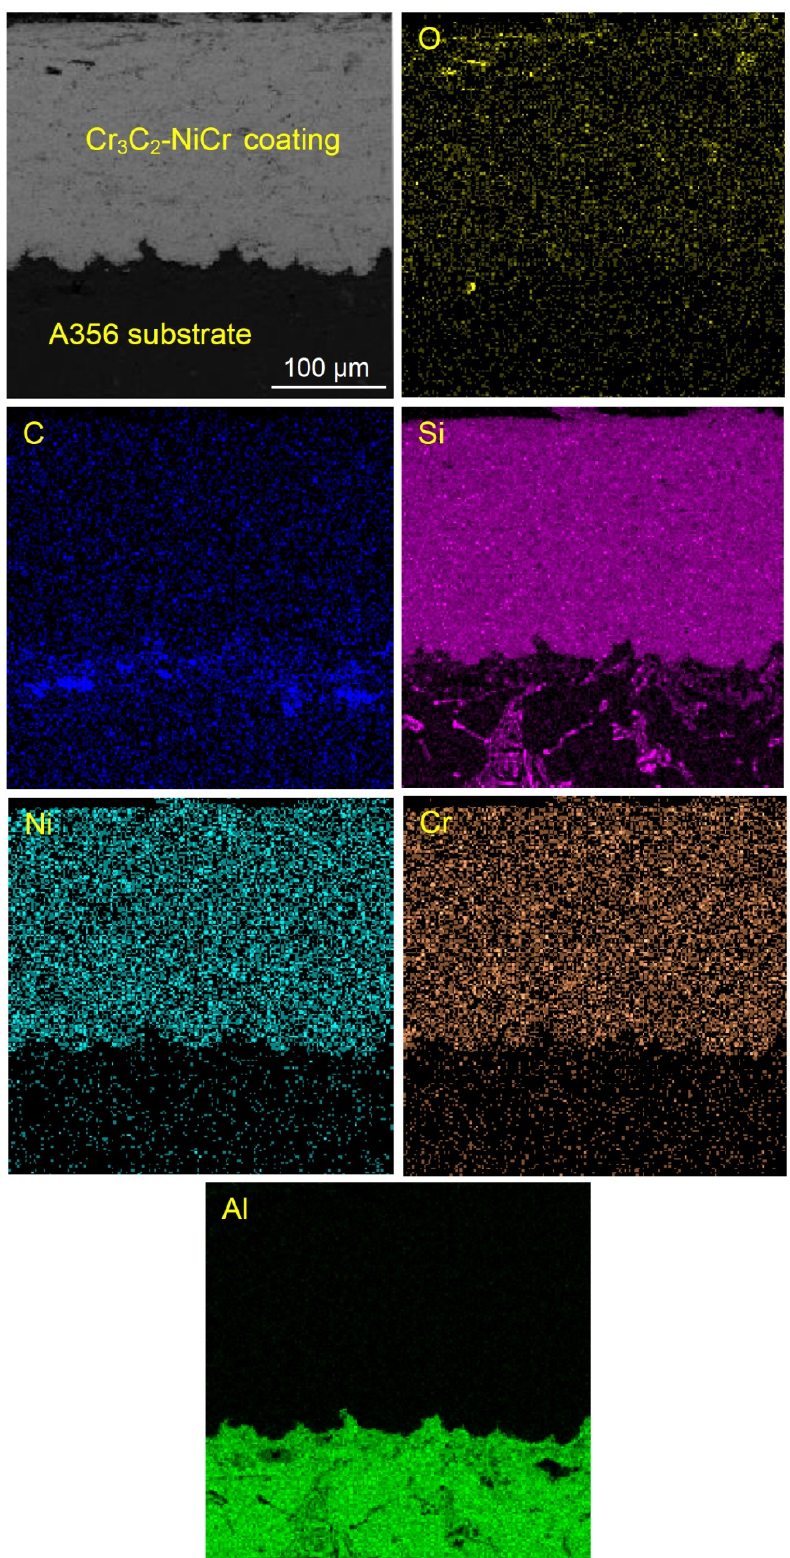
Figure 3. EDS elemental mapping on the cross-section of HVOF-sprayed Cr 3 C 2 -NiCr coating on A356 substrate.